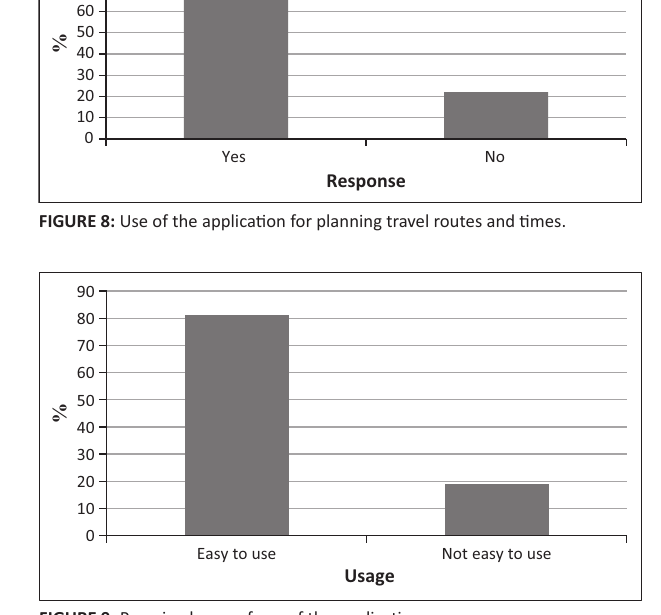
FIGURE 9: Perceived ease of use of the